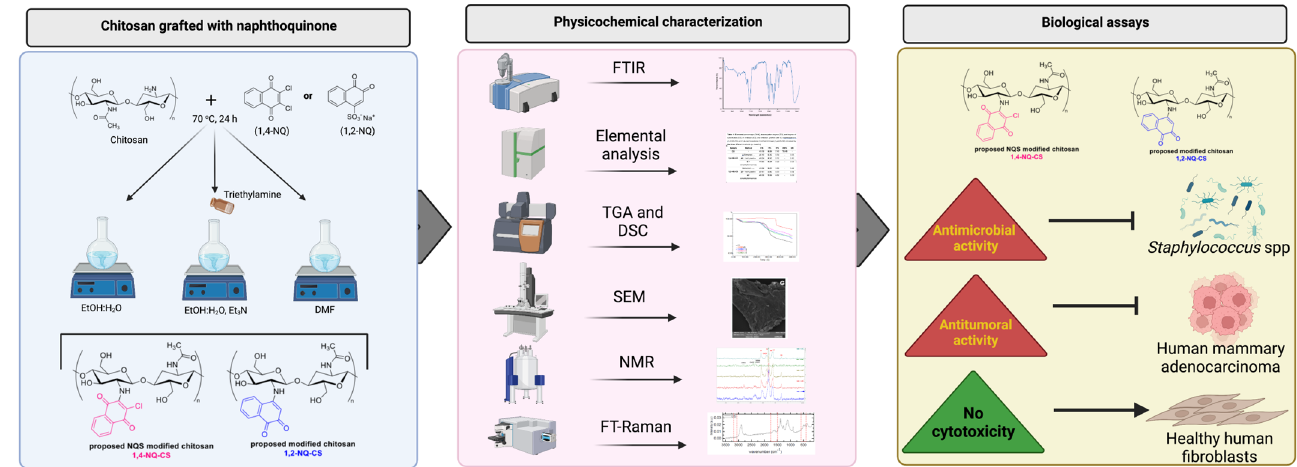
Figure 1. Experimental steps and analysis of naphthoquinone − grafted chitosans. Production of chitosan-naphthoquinone derivatives were performed by three different methods followed by analy- ses and physicochemical characterizations of the modified polymers, evaluation of antimicrobial and antitumoral effectiveness and cytotoxicity